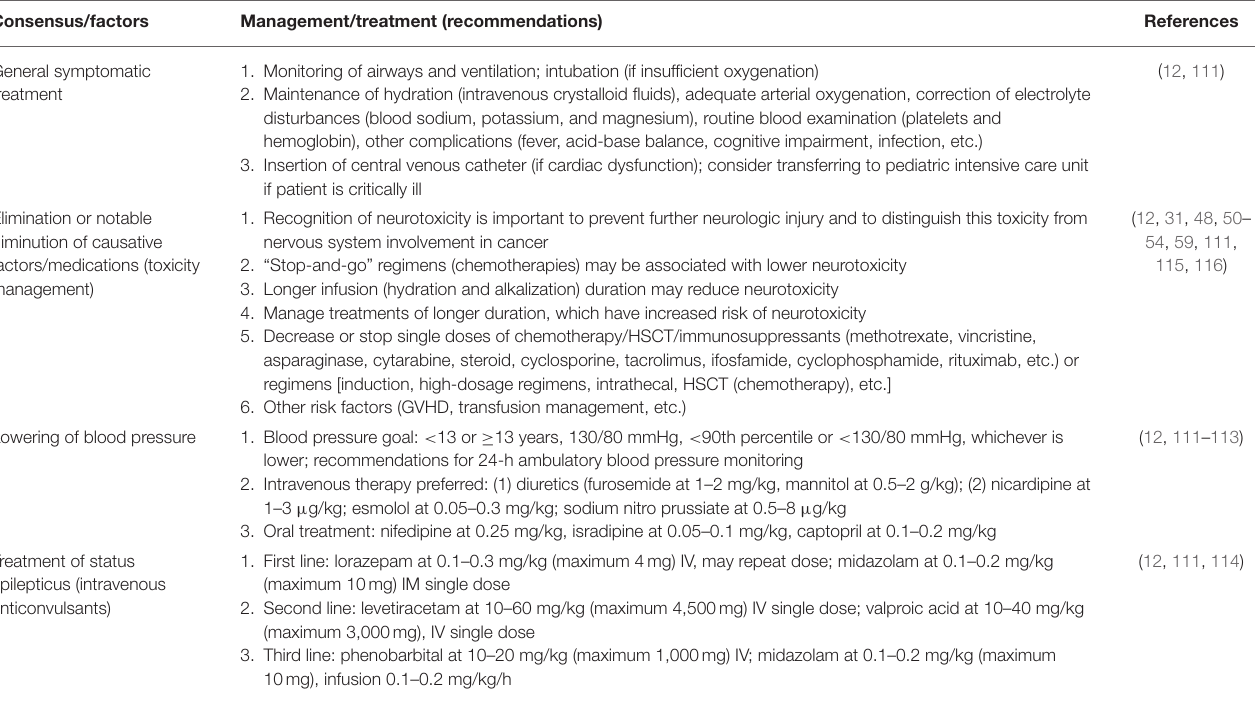
TABLE 5 | Management or treatment protocol for PRES in pediatric oncologic/hematologic diseases. Consensus/factors Management/treatment